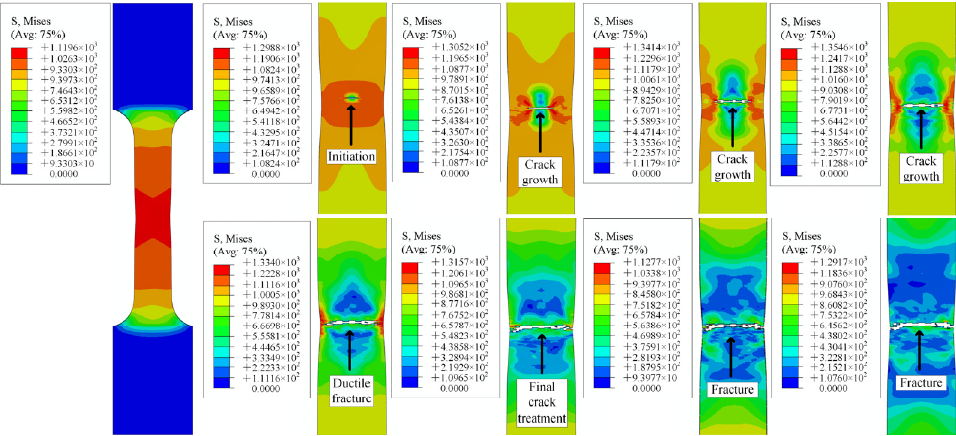
Figure 13. ABAQUS simulation of crack behavior.